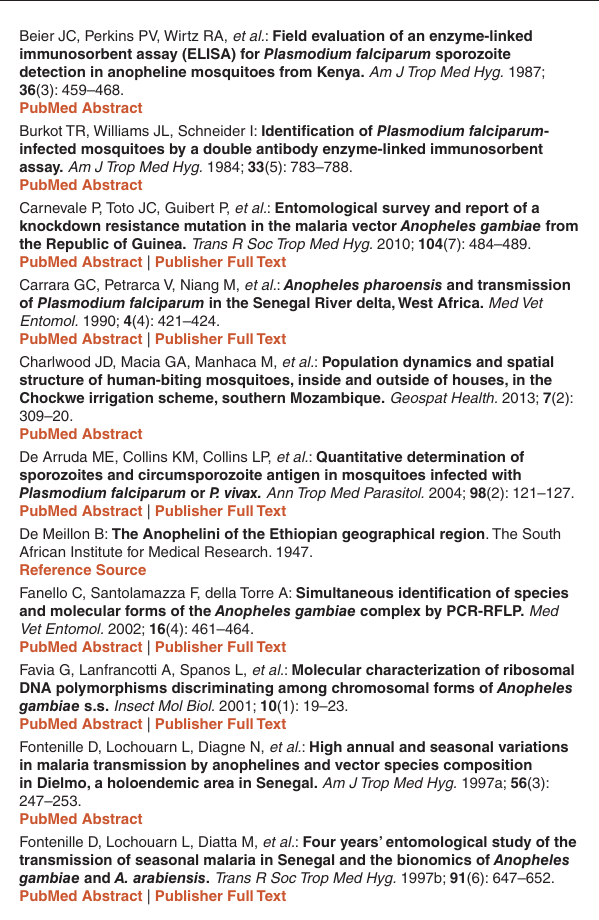
figshare: ELISA results identifying Plasmodium falciparum infec- tion status in Anopheles spp. collected in Guinea-Bissau. doi: 10.6084/m9.figshare.1200058 (Sanford et al. ,